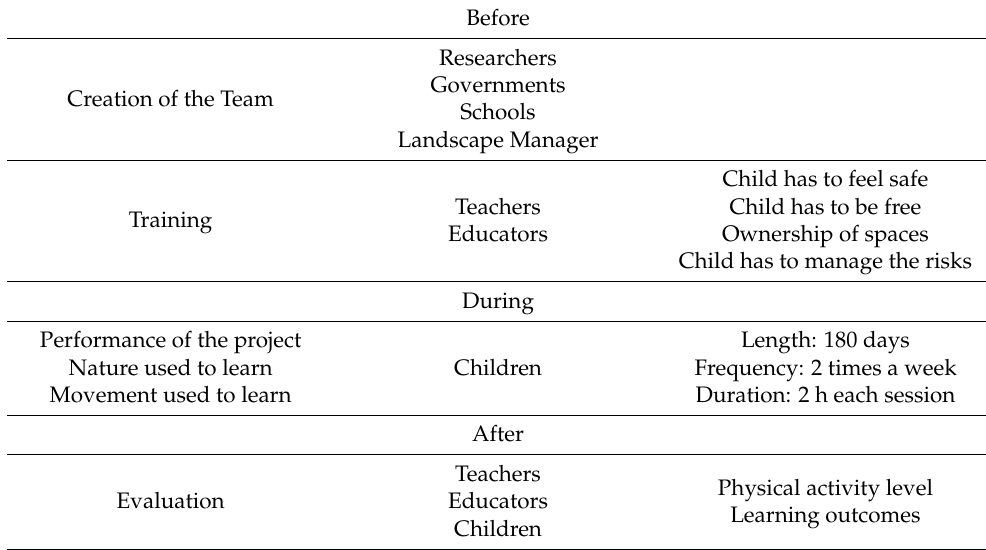
Table 2. Standard Operating Procedure for a natural movement-based